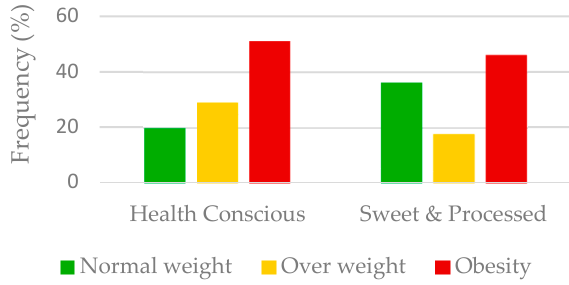
Figure 2. Frequency distribution of BMI subgroups in children and adolescents in each dietary cluster (GENOBOX cohort). Table 2. Descriptive characteristics of Spanish children and adolescents by dietary cluster (GENOBOX